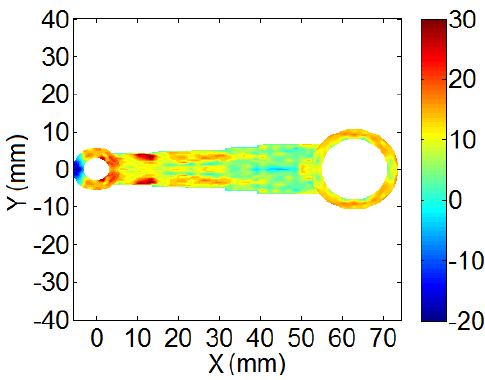
Figure 9. Differences in microhardness between the optimum connecting rods for each starting